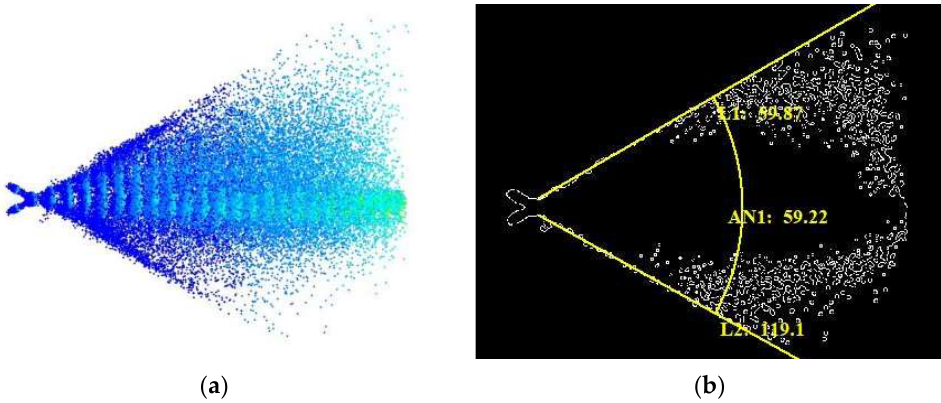
Figure 7. The identification process and the results for the atomization cone angle: ( a ) original image; ( b ) measurement results for the atomization cone angle.